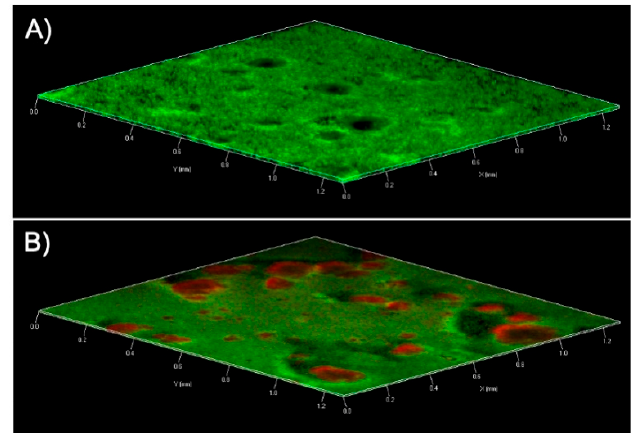
Figure 4. Peptide 8 effects on MRSP mature biofilm assessed by Confocal laser microscopy. ( A ) Untreated biofilm; ( B ) treated biofilm (32 μ g/mL).